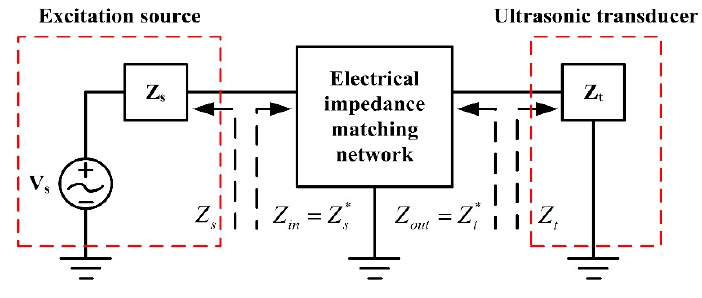
Figure 1. A simplified configuration of an ultrasonic transmitter.